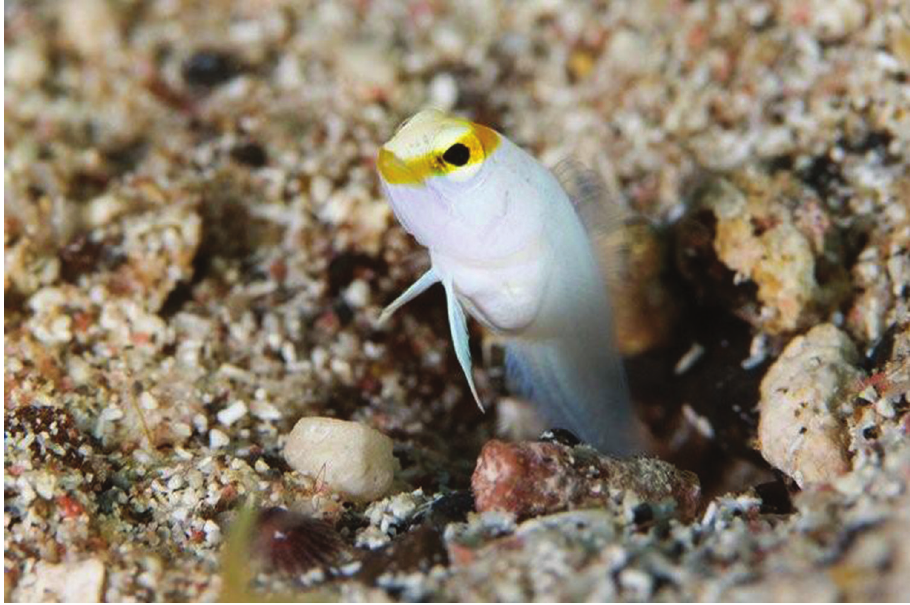
Figure 21. Opistognathus aff. aurifrons , juvenile, Fernando de Noronha Archipelago, Brazil. Photograph by João P.